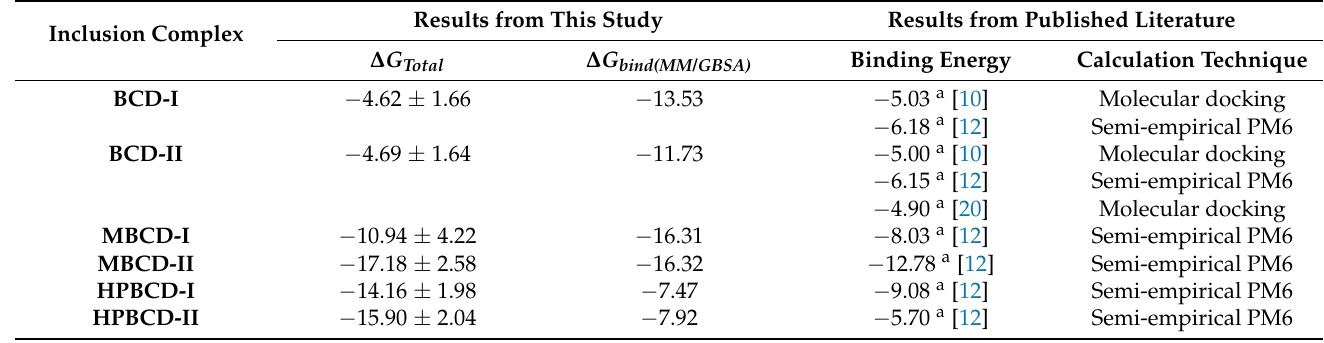
Table 2. Comparison of binding energy and total energy difference of plumbagin–BCDs inclusion complexes during the bound state in kcal/mol, with published results from the literature. Results from This Study Results from Published Literature Inclusion Complex ∆ G ∆ G Total bind(MM/GBSA) Binding Energy Calculation